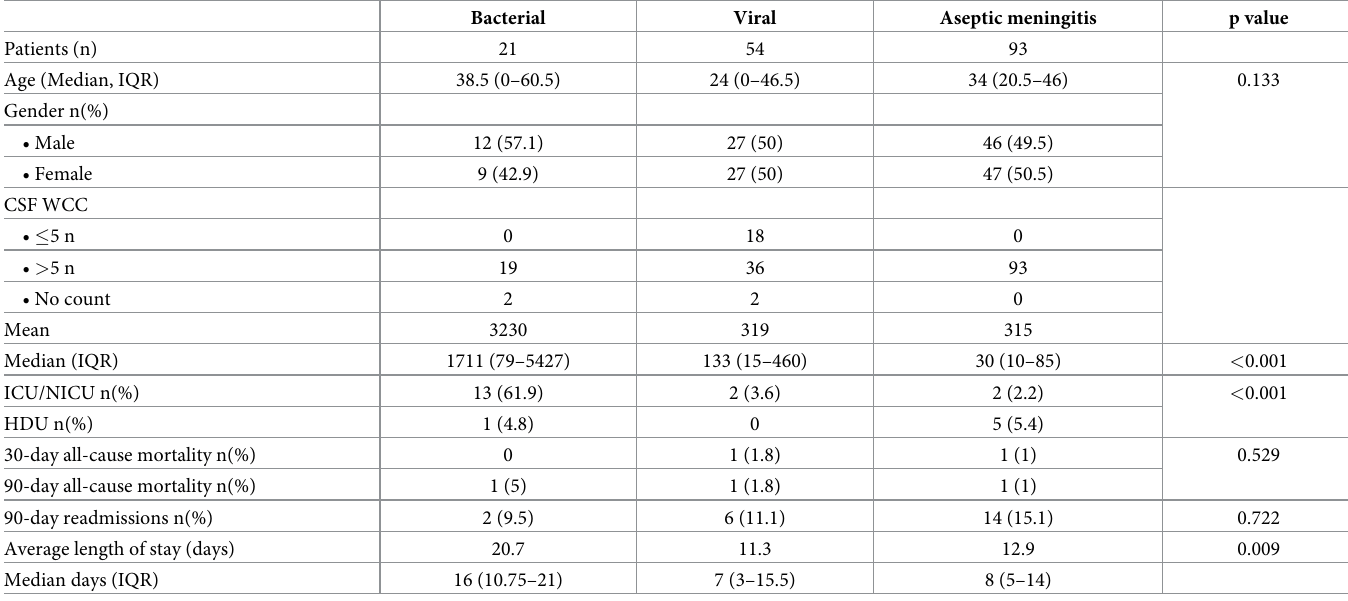
Table 4. Patient characteristics and outcomes for 3 subgroups